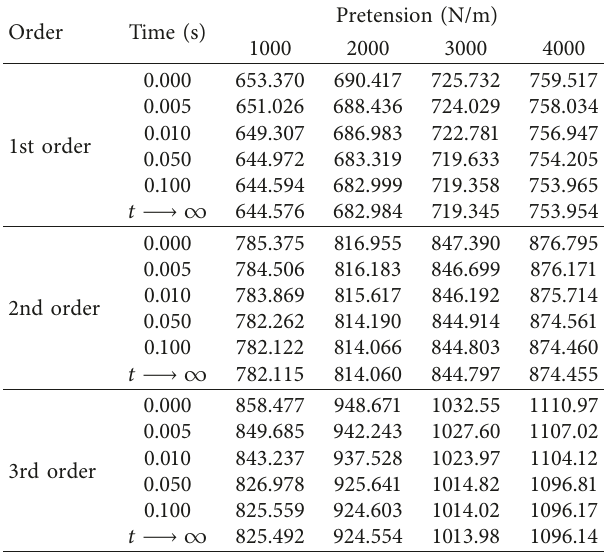
Table 5: Frequencies (rad/s) under different pretensions and time instants.